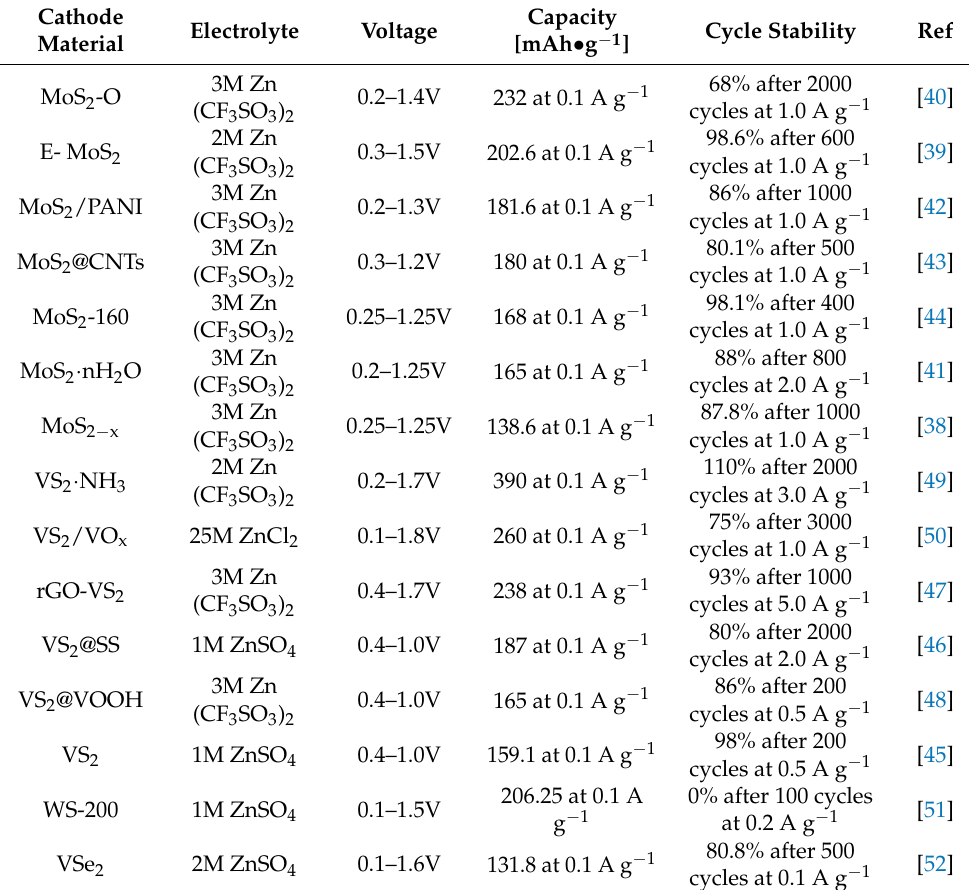
Table 2. Summary of the electrochemical performance of TMDs as ZIBs